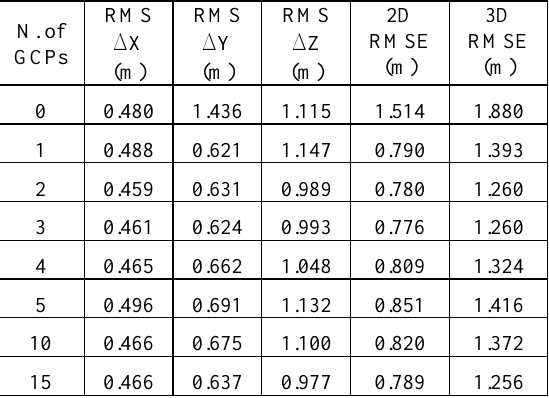
Table 2. RMS values calculated for each GCP configuration using a constant set of 17 CP